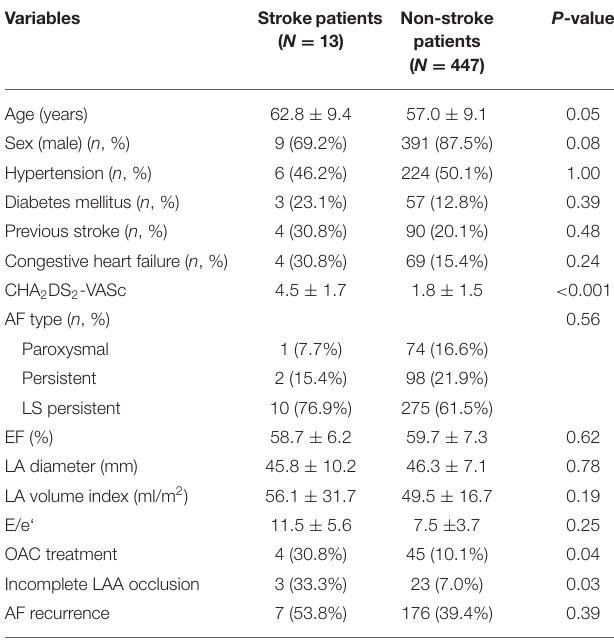
TABLE 1 | Baseline characteristics of overall population. TABLE 2 | Baseline characteristics between patients with or without